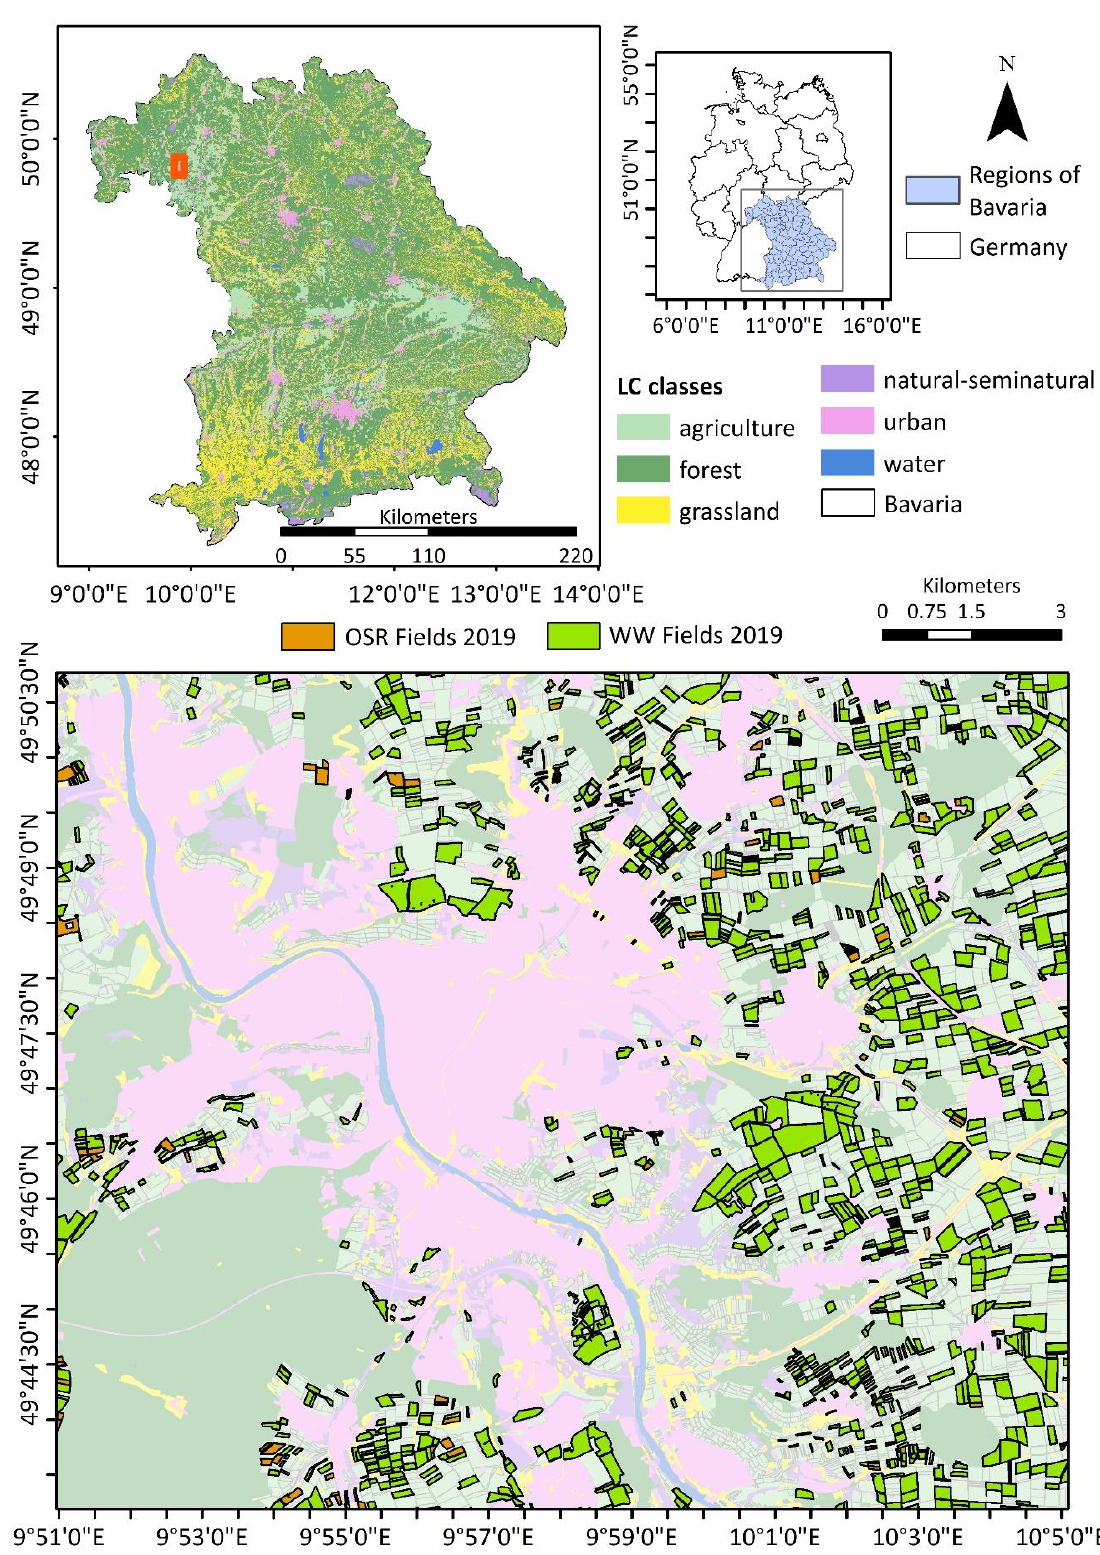
Figure 2. Overview of the study region. The LC map of Bavaria is obtained by combining multiple inputs of landcover maps, such as the Amtliche Topographisch-Kartographische Informations System, Integrated Administration Control System (which provides the crop field information), and the Corine LC, into one map. Agriculture (peach green) dominates mainly in the northwest and southeast of Bavaria, while forest and grassland classes (dark green and yellow, respectively) dom-